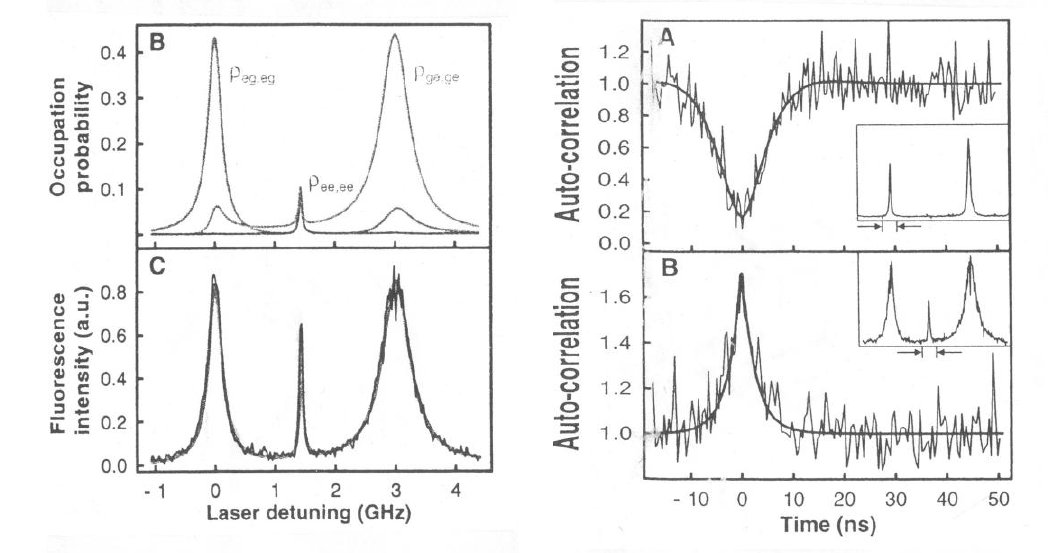
Figure 2. Left panel: B: Occupation probability and C: fluorescence intensity at slight de-tuning of a laser source for two emitters at a distance of 12 nm. Right panel: A: Antibunching when the laser is tuned either to molecule 1 or to molecule 2. B: Bunching when it is tuned to the cross peak. Reproduced from